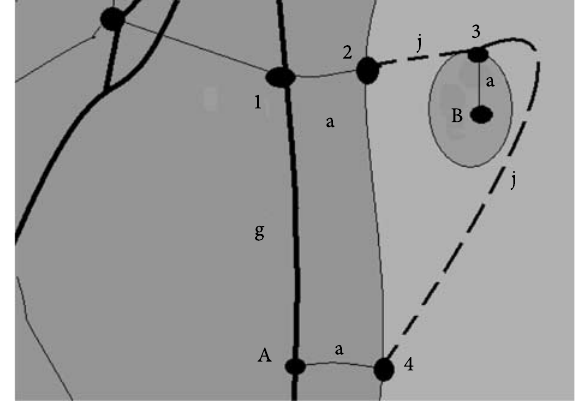
fig. 1. A schematic view of routes for freight